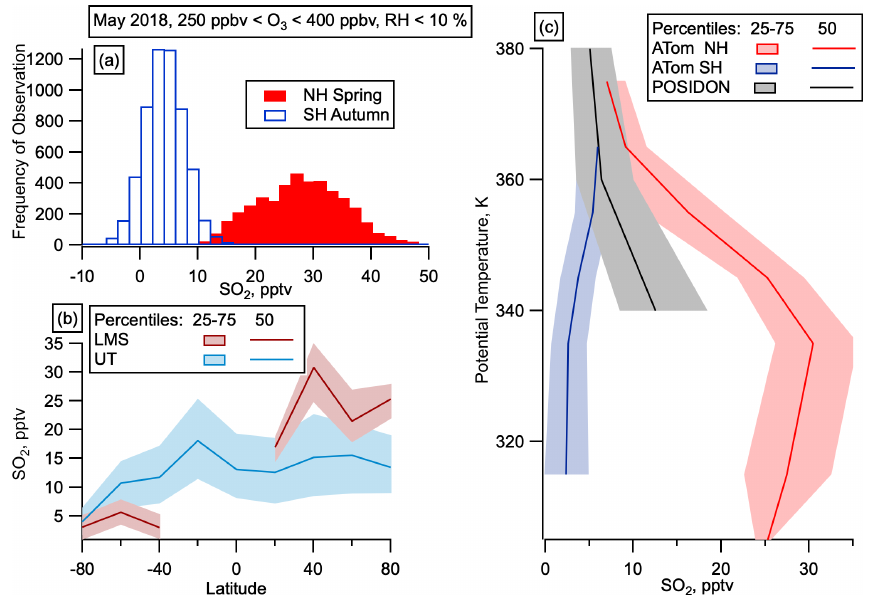
Figure 5. SO 2 in the LMS. (a) Mixing ratios of gas-phase SO 2 in the LMS (250ppbv < O 3 < 400ppbv) in the SH (open blue) and NH (filled red). (b) Median and interquartile range of SO 2 by latitude in May for the LMS (red) and UT (Blue) in May. UT is defined as altitudes over 8km and O 3 < 250ppbv or RH w > 10%. SO 2 observations at mixing ratios below 100pptv are only available for the May 2018 deployment. (c) SO 2 mixing ratios as a function of potential temperature from the tropical UT on POSIDON, October 2016, and from the LMS on ATom, May